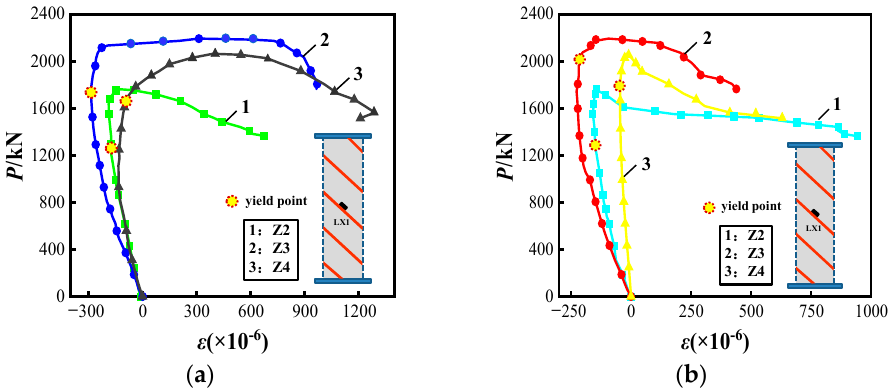
Figure 11. Load–strain relationship in the spiral rib: ( a ) Strain in the compression zone; ( b ) Strain in the tensile zone. Strain in the steel bar and vertical plate Reinforcing bars and vertical plates are used as external concrete restraining mem-